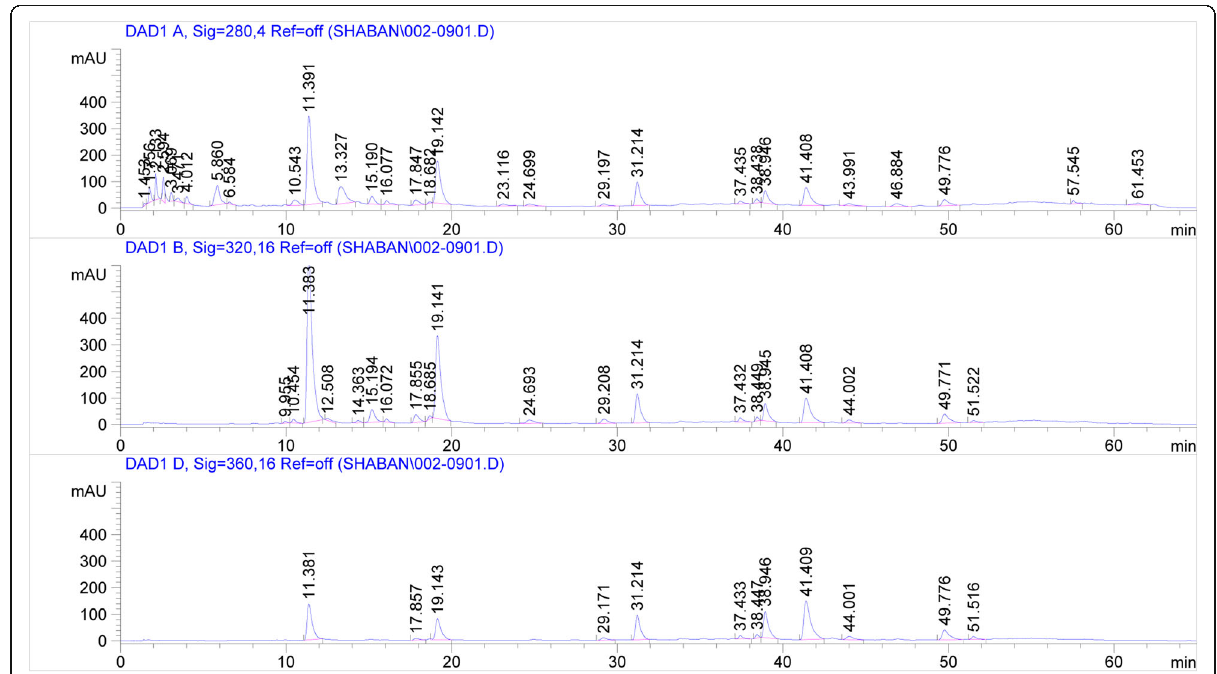
Fig. 1 High-performance liquid chromatography chromatograms of Moringa oleifera extract, at wavelengths 280 nm, 330 nm, and 360